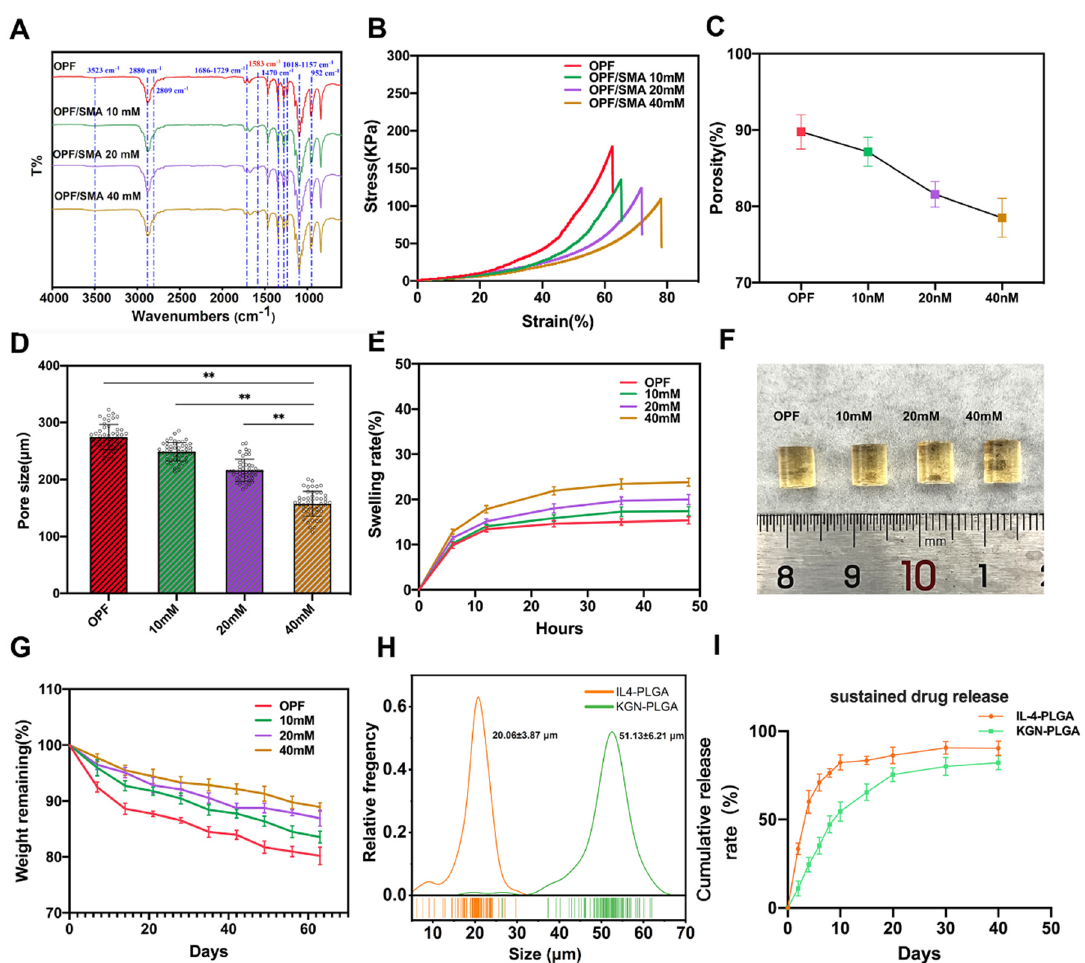
Figure 2. Characterization and analysis of OPF/SMA hydrogel scaffolds and PLGA microspheres. ( A ) Fourier transform infrared spectroscopy (Thermo Scientific Nicolet 6700, Waltham, MA, USA) was used to characterize the changes of functional groups on OPF and OPF/SMA. Potassium bromide was used to press the tablets in the infrared, and the infrared wavelength range was (4000–400 cm − 1 ). ( B ) The compression modulus of OPF/SMA hydrogel scaffold was measured. ( C , D ) The porosity was calculated with the ethanol exchange method. The pore size of OPF, OPF/SMA 10 mM, OPF/SMA 20 mM, and OPF/SMA 40 mM was quantified from SEM images with ImageJ. ** p < 0.01. ( E , F ) Swelling diagram of hydrogel. Soak the hydrogel in ddH2O for 48 h. Statistical significance was calculated by t -test. ( G ) In vitro degradation curves of OPF, OPF/SMA 10 mM, 20 mM, and 40 mM hydrogels in PBS at 37 °C. ( H ) The particle size of the freeze-dried PLGA microspheres was analyzed with ImageJ software 2.3.0 (NIH, USA) using SEM pictures. ( I ) Entrapment rate and in vitro sustained release of PLGA microspheres ( n = 3).